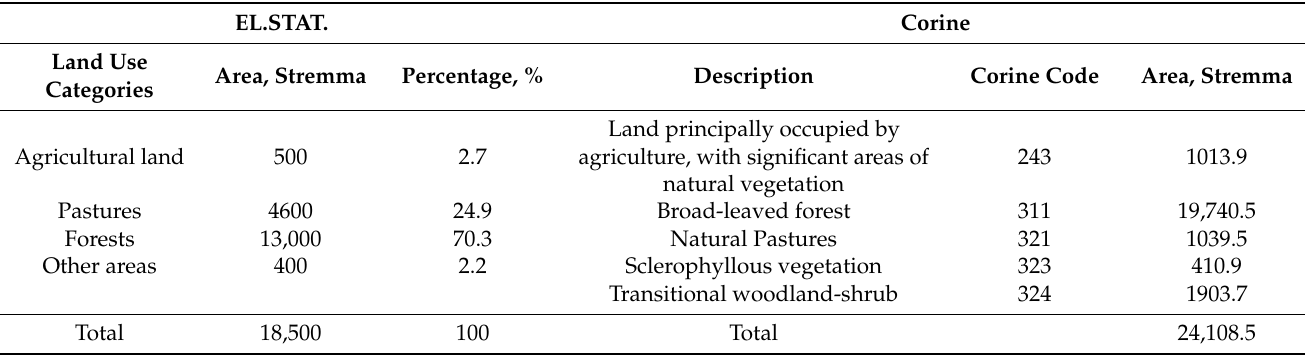
Table 1. Distribution of land uses in the Pisoderio Pasture EL.STAT. and by Corine. EL.STAT.